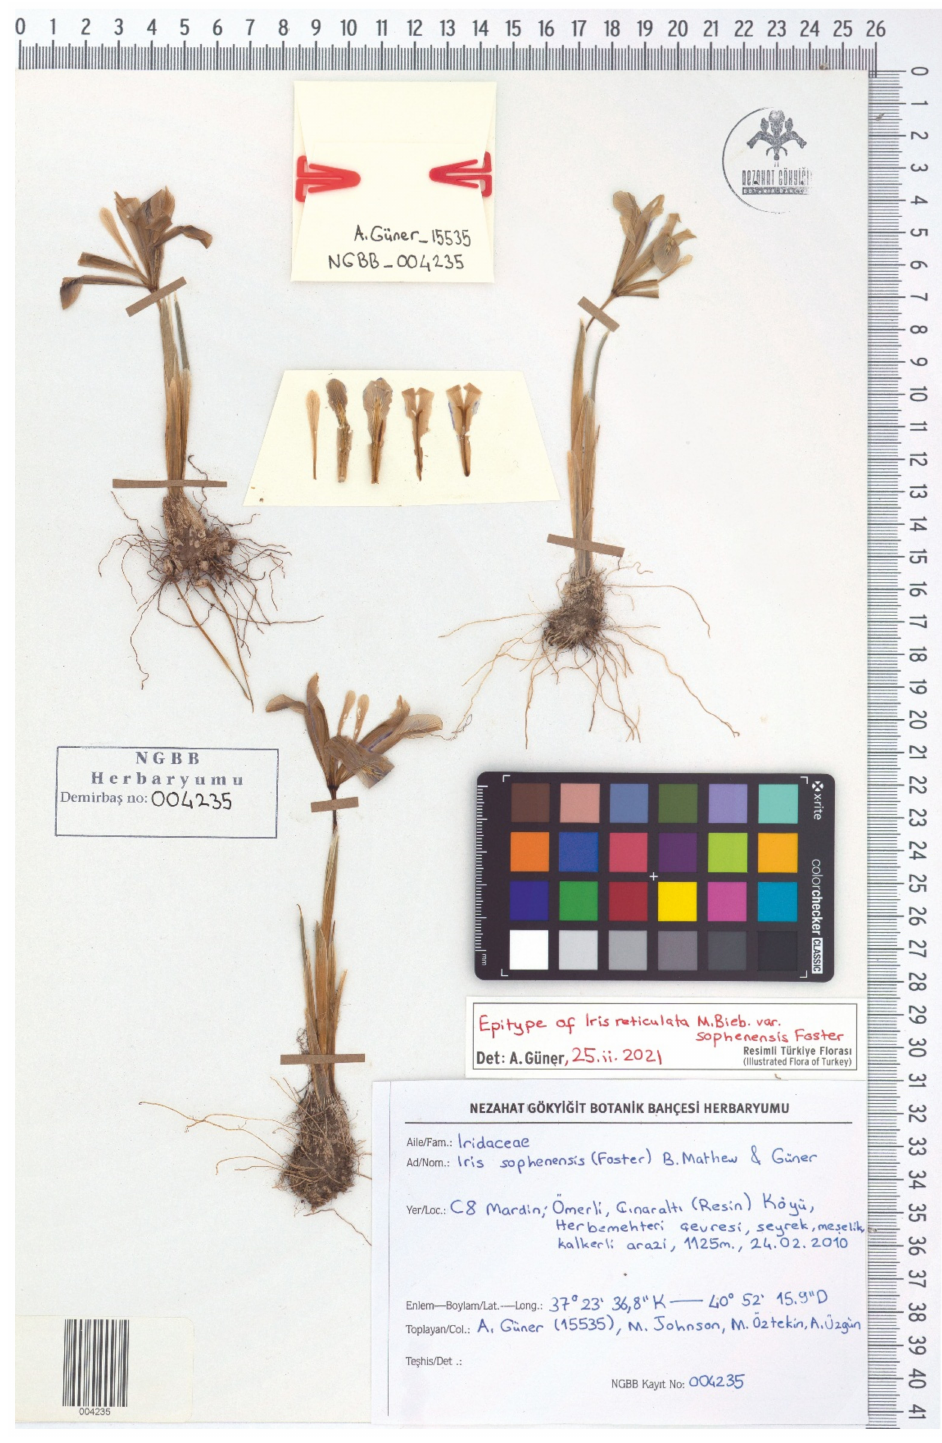
Figure 5. Epitype of Iris reticulata var. sophenensis (NGBB004235), by permission of the Curator. Notes — Iris reticulata var. sophenensis was described and introduced into cultivation by Foster based on the plants from the bulbs sent by Mary E. Barnum from the American Mission at Harput (Elazı˘g Province, Turkey) in October 1884 [34]. These bulbs were gathered by Barnum in Sophene, the ancient name of the area around Harput. We found a specimen represented by a cultivated plant (K000499061!), which is the original material for the name. This sheet is accompanied by an envelope with dissected flowers and a colour illustration of the flower organs, together with Foster’s letter to J. Baker.